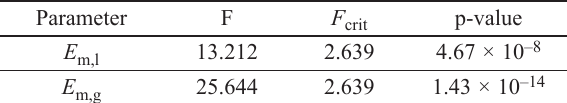
Table 2. Single-factor ANOVA results for parameters E m,l and E m,g with respect to different visual strength classes